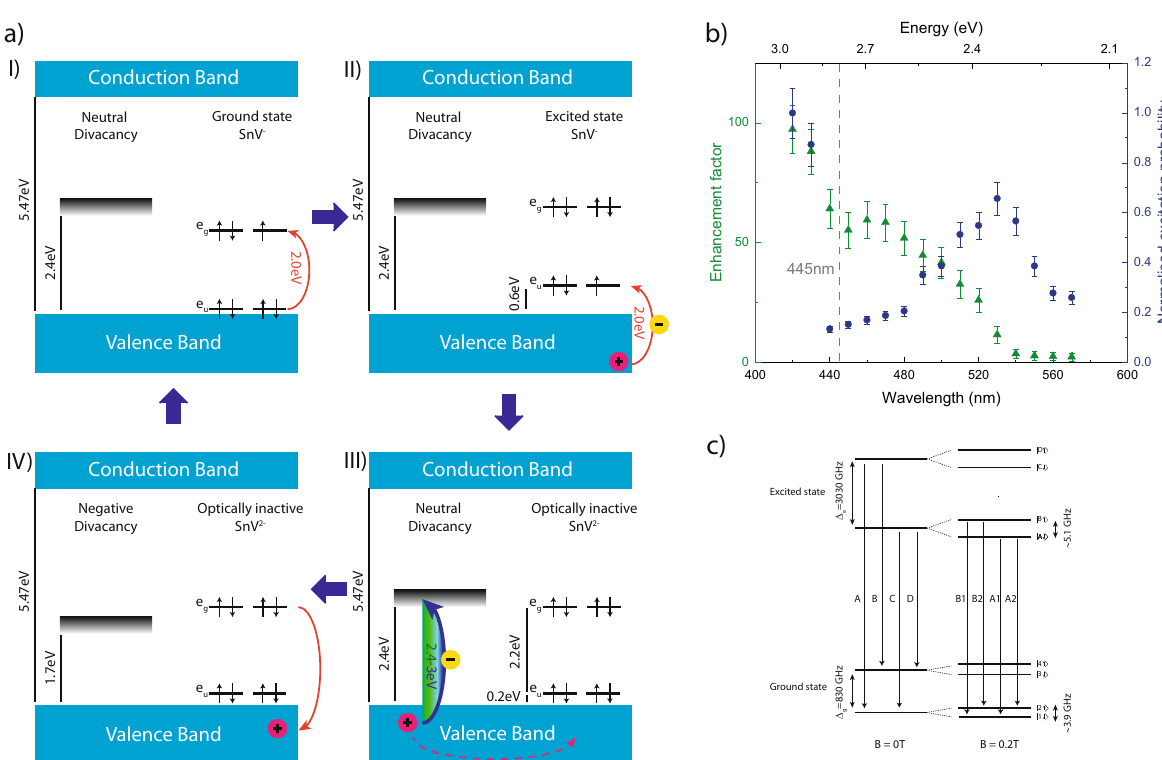
Fig. 1 Charge processes of the SnV − centre. a Proposed scheme for the charge cycle of the SnV centre. In (I) the SnV − centre gets excited by a resonant 2 eV photon. In (II) a second 2 eV photon promotes an electron from the valence band to the SnV − centre, transforming it into its optically inactive charge state SnV 2 − . In (III) a photon with an energy above 2.4 eV drives the charge transition of a defect in the diamond lattice, most likely the neutral divacancy. In this process a hole is created in the valence band which diffuses in (IV) towards the SnV 2 − centre, where a recombination takes place. All absolute energy positions related to the charge states of the SnV − centre are extracted from ref. 19 . b Enhancement of fl uorescence factor of an ensemble of SnV − centres, excited resonantly on the C-transition and under addition of a second laser with tunable wavelength. The enhancement factor is de fi ned as the ratio between counts with and without the second laser. For comparison, the normalised excitation probability measured via excitation by the second laser only is plotted. The excitation probability peaks at 2.4 eV due to excitation to a higher excited state of the SnV − 6 and an indication of an even higher lying excited state is seen at photon energies larger 2.8 eV most likely resulting from a deeper lying electron state in the valence band 19 . y-errors (s.d.): Poisson distributed count rate errors. c Fine structure and Zeeman splitting of the SnV − centre. The relevant optical transitions and splittings at B = 0 T and B = 0.2 T for this work are